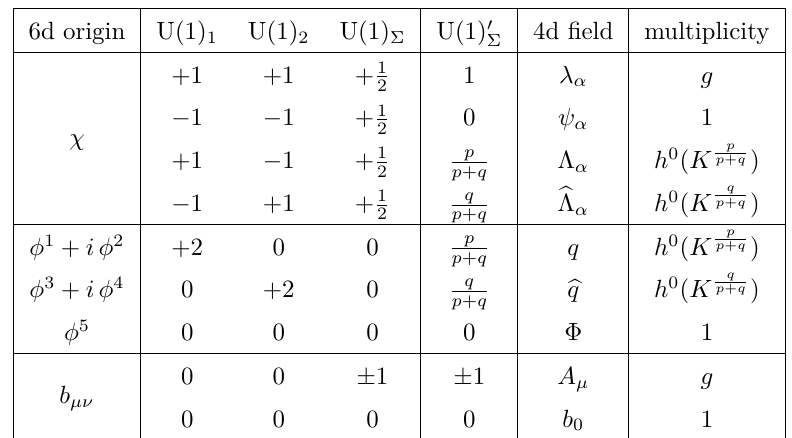
Table 3 . Massless 4d fields originating from dimensional reduction of a 6d N = (2 , 0) free tensor multiplet on a genus- g Riemann surface ( g 6 = 1 ) with twist parameters p , q satisfying p + q = 2( g − 1)